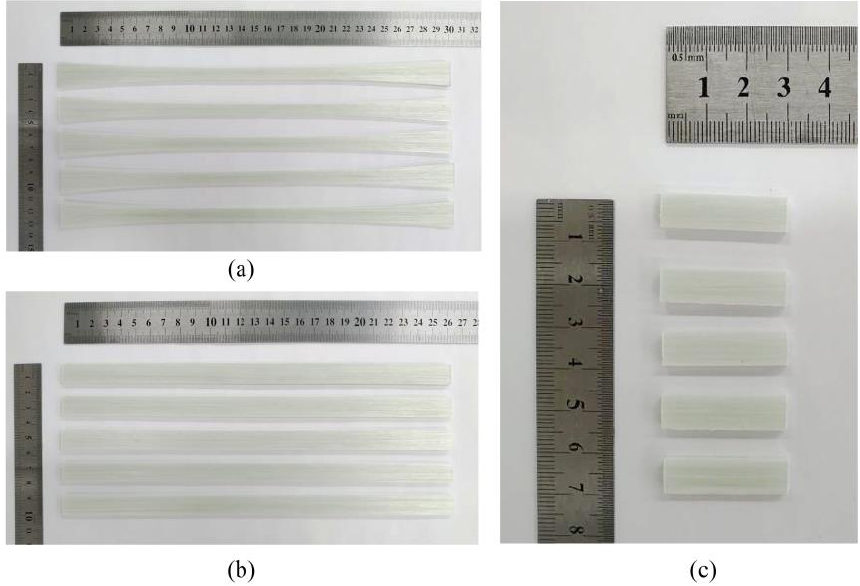
Figure 9. Mechanical test specimens machined from pultruded GF/PP flat laminates based on in-house-made PCTs: ( a ) tension test specimens; ( b ) flexure test specimens; ( c ) short-beam shear test specimens.